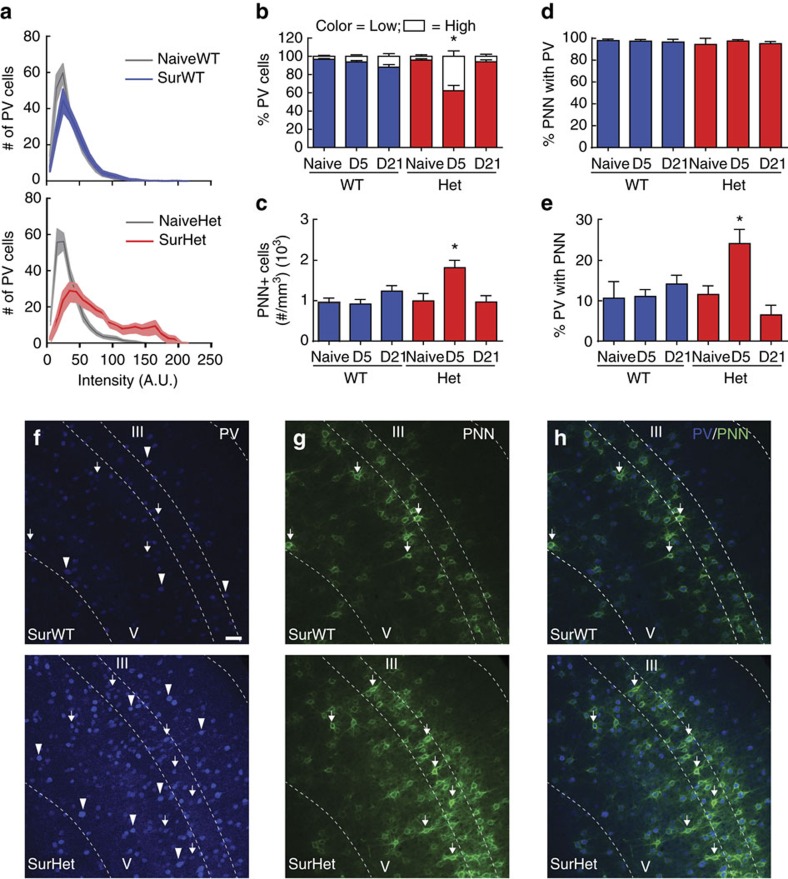
Female Mecp2het mice exhibit abnormal maternal experience-induced changes to inhibitory networks in the auditory cortex.(a) Histograms showing the mean distribution of PV cell intensity in adult surrogates 5 days after pup exposure (D5). Top panel, distribution of PV cell intensity is similar between SurWT (dark blue) and NaiveWT (grey). Bottom panel, there is a shift in the distribution toward elevated PV expression in SurHet (red) compared with NaiveHet (grey) (n=2704–4906 PV+ cells, 19–20 images, 5 mice for each group). The solid line and shaded region represent mean±s.e.m. respectively, in both panels. (b) The shift reflects a significant transient increase in high-PV expressing cells at D5 that returned to baseline at D21 in SurHet (ANOVA: Tukey's post-hoc test, *P<0.05 compared with all other groups). (c) The density of high-intensity perineuronal nets (PNNs) was significantly increased only in SurHet at D5 (n=292–1735 PNN+ cells, 12–38 images, 3–9 mice; ANOVA: Tukey's post-hoc test, *P<0.05 compared with all other groups), and returned to baseline at D21. (d) The percentage of PNN co-localizing with PV-expressing cells was not significantly different across genotypes and conditions (n=1–107 PNN+ cells, 1–103 PV cells, 6 images, 3 mice; ANOVA: Tukey's post-hoc test, P>0.05). (e) However, the percentage of PV cells co-localizing with PNN was significantly higher in SurHet at D5 (n=92–319 PV cells, 1–103 PNN+ cells, 6 images, 3 mice; ANOVA: Tukey's post-hoc test, *P<0.05 compared with all other groups except SurWT P21). (b–e) Bar graphs represent mean±s.e.m. (f–h) Representative confocal images taken from the auditory cortex of a SurWT and SurHet showing relative expression of PV (f) and PNN (g). Arrowheads indicate high-intensity PV cells. Arrows point to co-localization of PV and PNN. Scale bar, 50 μm, applies to all images. Dashed lines delineate cortical layers with layers III and V indicated.